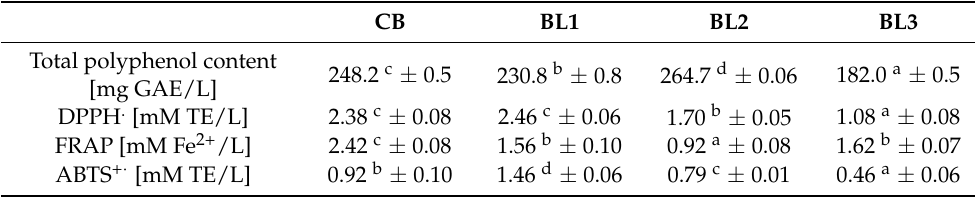
Table 2. Total polyphenol content and antioxidant activity of wheat beers.